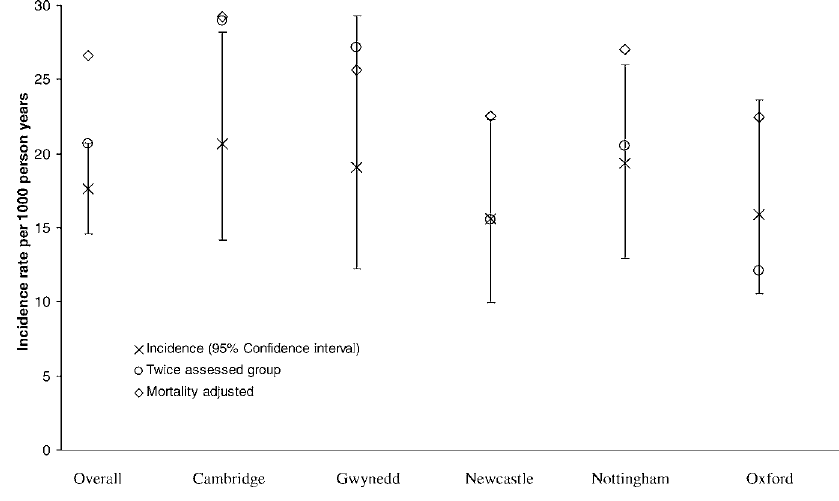
Figure 2. Centre Effects for the Three Different Incidence Models DOI: 10.1371/journal.pmed.0020193.g002 PLoS Medicine | www.plosmedicine.org August 2005 | Volume 2 | Issue 8 |